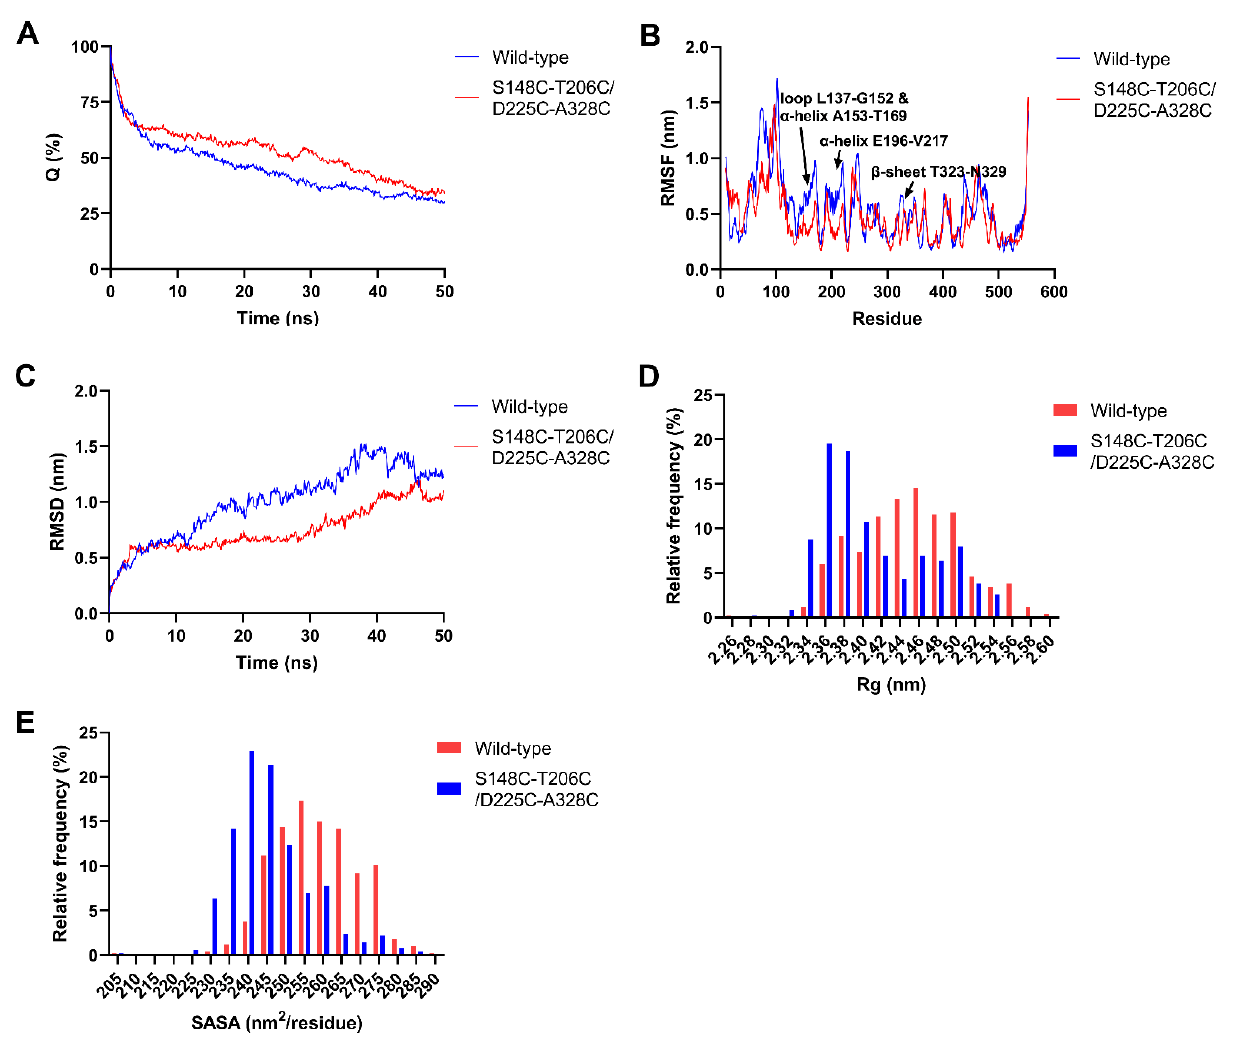
Figure 3. MD simulation analysis of wild-type MsPLD and mutant S148C-T206C/D225C-A328C. ( A ) Time courses of the fraction of native contacts (Q). ( B ) The difference in Cα RMSF of mutant S148C-T206C/D225C-A328C versus that of wild-type MsPLD. ( C ) Time courses of RMSD value. ( D ) The relative frequency distributions of Rg. ( E ) The relative frequency distributions of hydrophobic SASA.